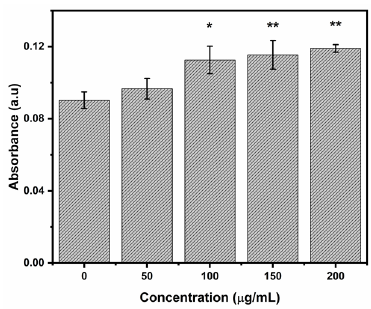
Figure 4. Iron release from hemoglobin in the presence of increasing concentrations of MSPs. Data are means ± SD of two independent experiments. * p -value < 0.05, ** p -value < 0.01 vs. control preforming one way analysis of variance (ANOVA) by Fisher’s comparison test.